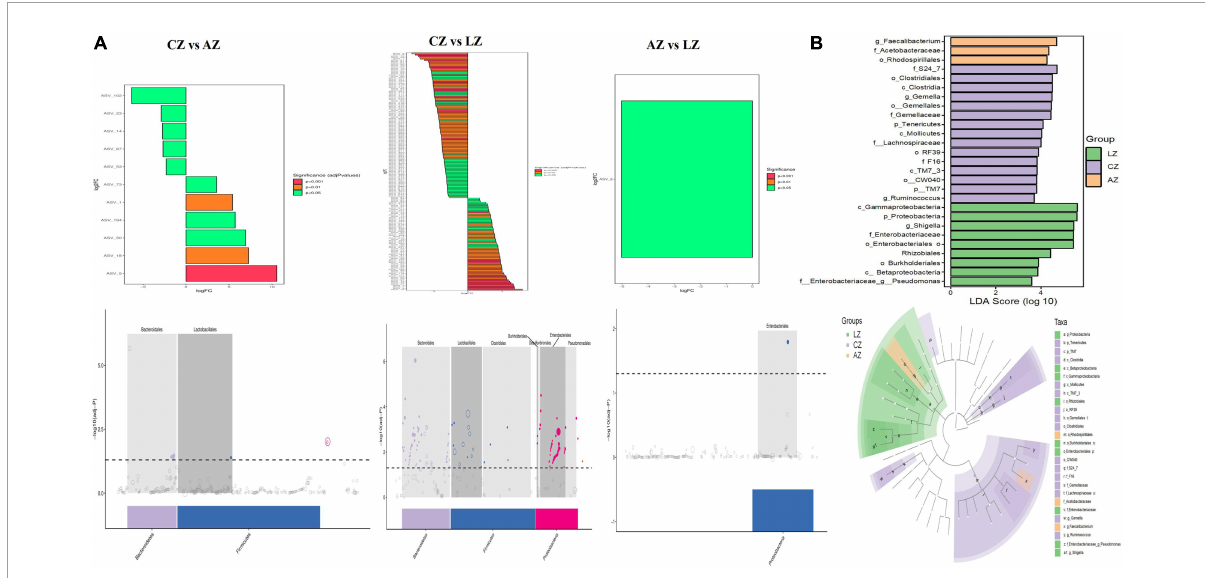
FIGURE8 Gut microbiota difference analysis between mouse groups. (A) MetagenomeSeq analysis and (B) LEfSe analysis.